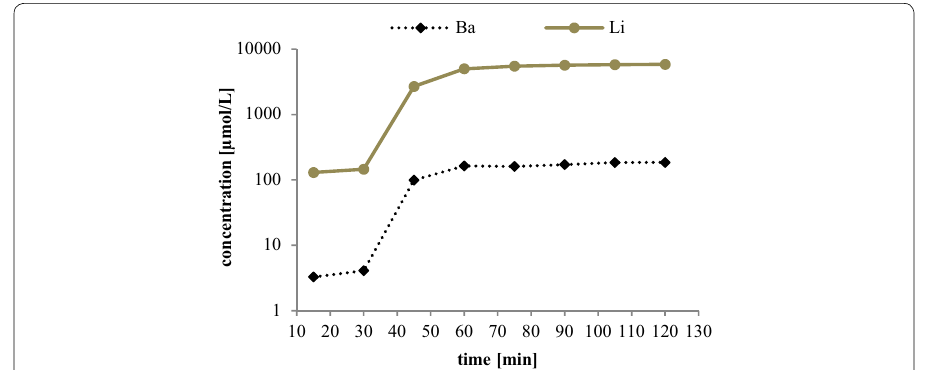
m. : 2 cm 3 /min, initial Li and B concentrations: 12,809